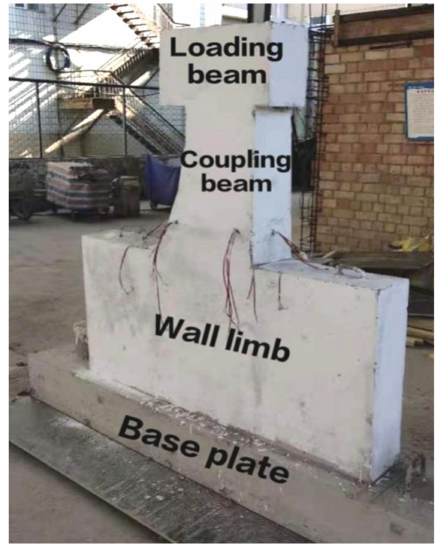
Figure 9. Completed